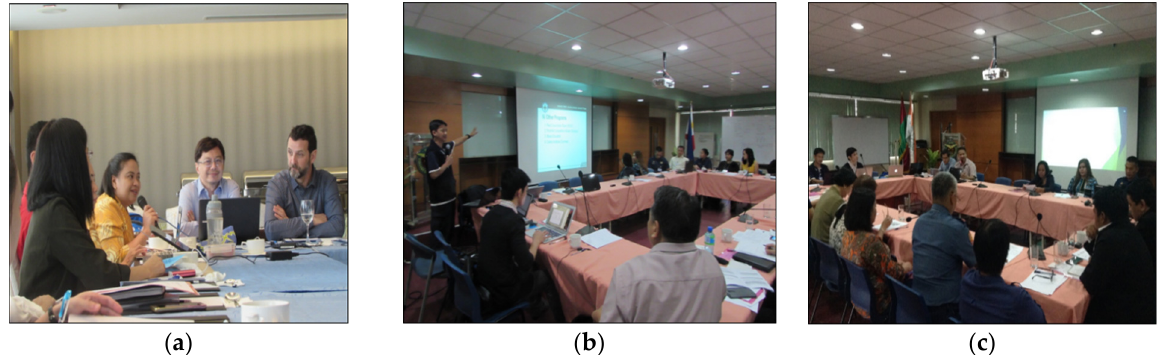
Figure 2. Consultative meetings: ( a ) Multisector action plan meeting with Dr. David Meddings of the WHO; ( b ) presentation of drowning prevention activities being implemented by one agency; ( c ) discussion on the contents of the Multisector Action Plan on Drowning Prevention.